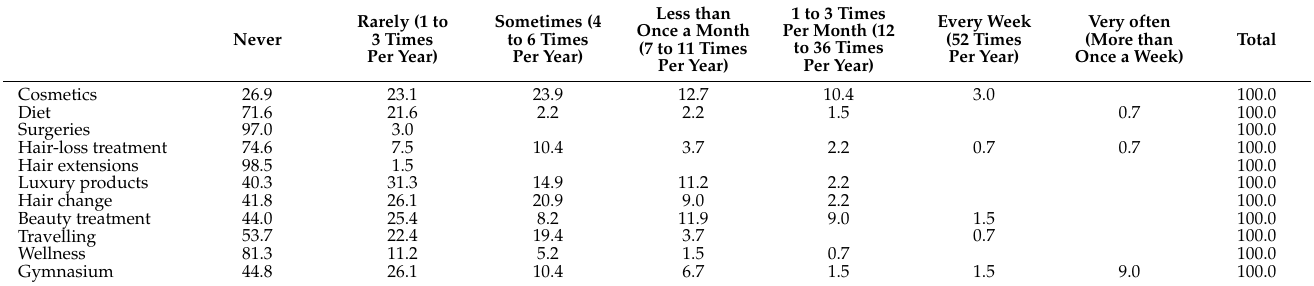
Table 4. Percentages of respondents that in the past made purchases as a compensation for body image